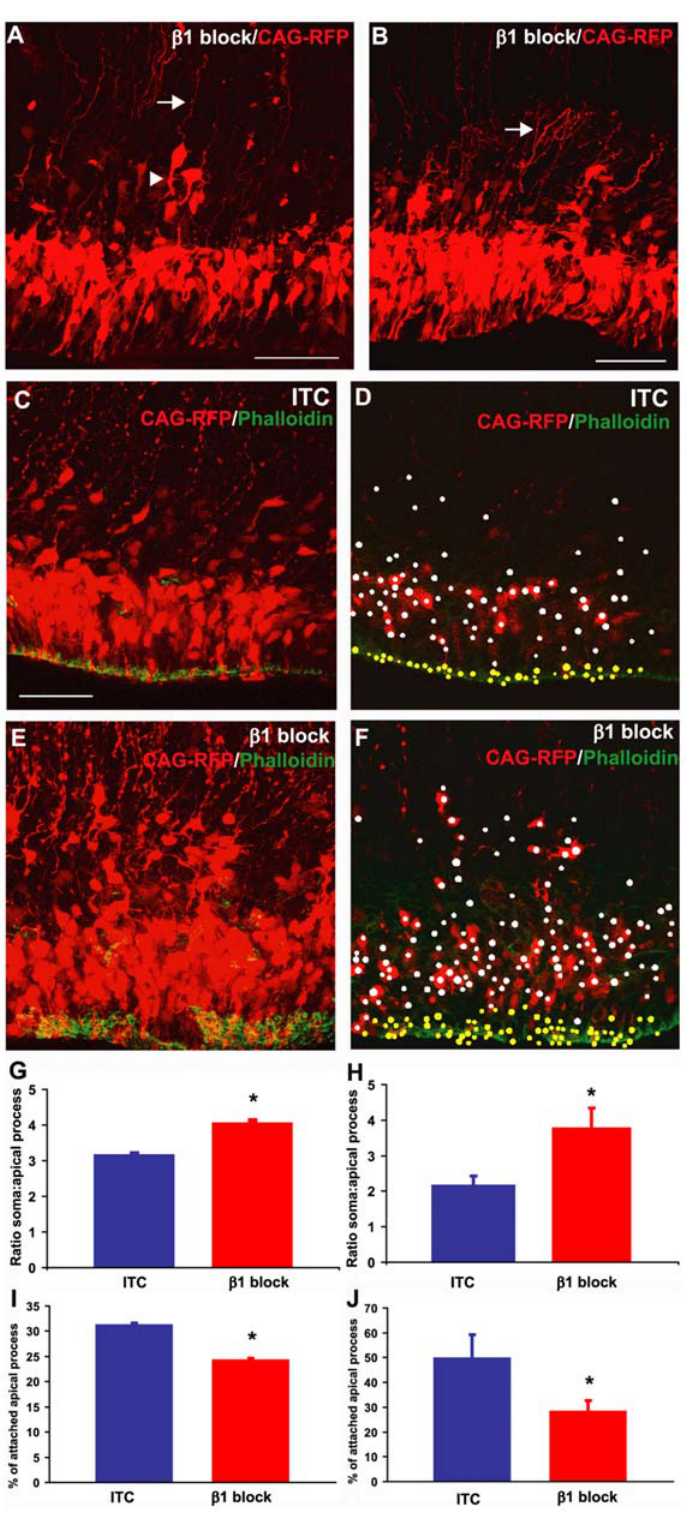
Figure 4. Inhibition of b 1 integrin signalling results in NSC detachment. (A–F) Confocal fluorescence micrographs showing the VZ/SVZ of embryos injected at E15.5 with either an ITC (C, D) or b 1 integrin blocking antibody (A, B, E, F) and simultaneously electroporated with CAG-RFP (red) and stained for phalloidin (green) 18 h later. (A) Note the bipolar morphology of the cell marked with an arrowhead and the dystrophic basal processes of detached cells (white arrows in A and B). (D, F) White and yellow dots represent soma and apical processes, respectively. (G, H) Quantification of the ratio of soma to apical processes in the co-injected/electroporated mouse brains at E13.5 (G) or E15.5 (H) and analyzed 18 h later. (I, J) Quantification of the percentage of apical processes still attached at the ventricular surface in the injected/electroporated brains at E13.5 (I) or E15.5 (J) and analyzed 18 h later. *, p , 0.05; unpaired two-tailed t -test. All scale bars represent 50 m m.